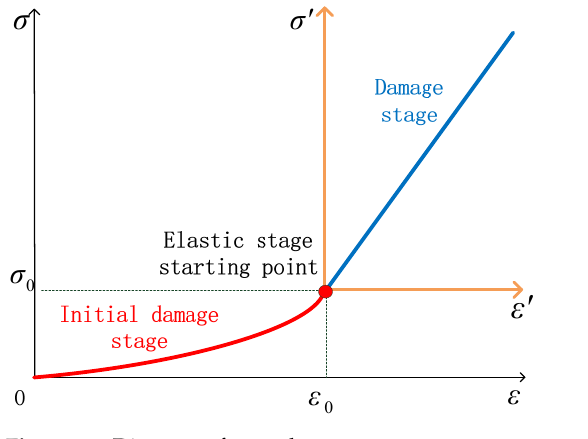
Figure 1 0 . Diagram of axes change. Figure 10. Diagram of axes change.